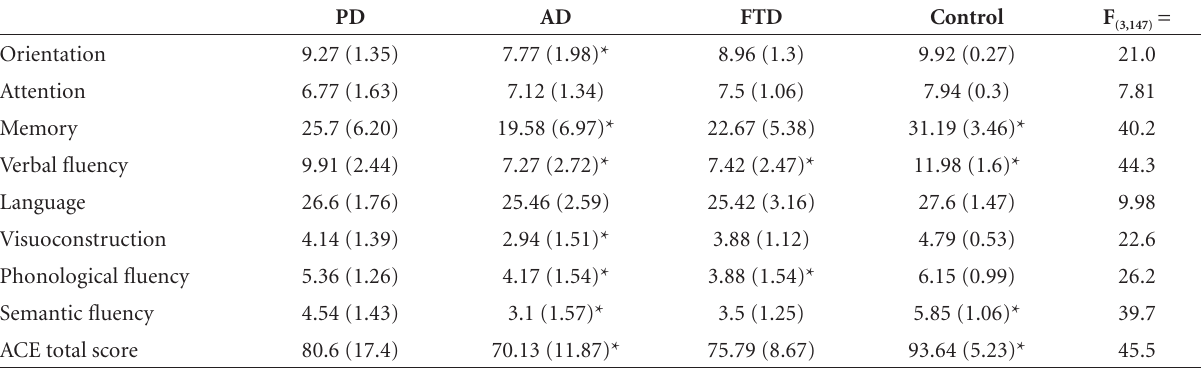
Table 2. Addenbrooke’s Cognitive Examination (ACE) cognitive sub-domain and total scores.